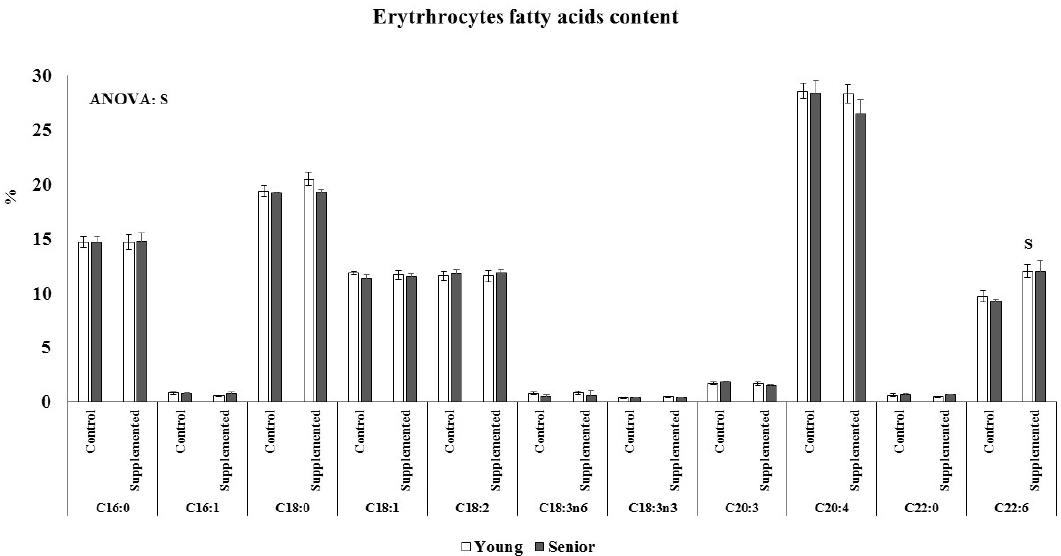
Figure 2. Effects of age and beverage supplementation on erythrocytes fatty acids composition.